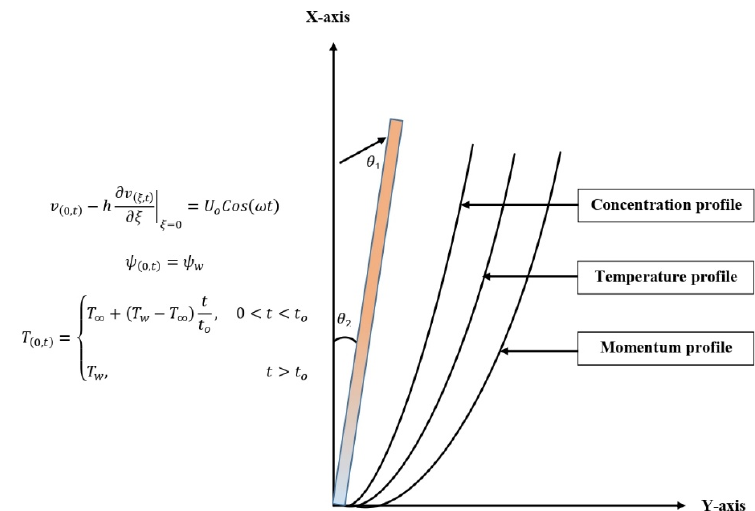
Figure 1. Flow Figure 1. Flow geometry.